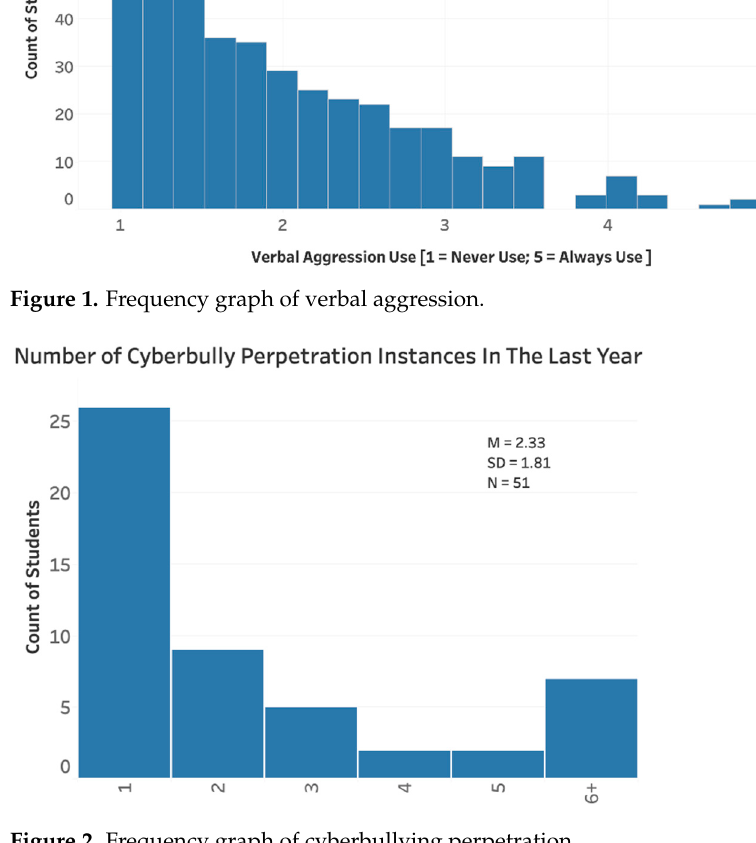
Figure 2. Frequency graph of cyberbullying perpetration.